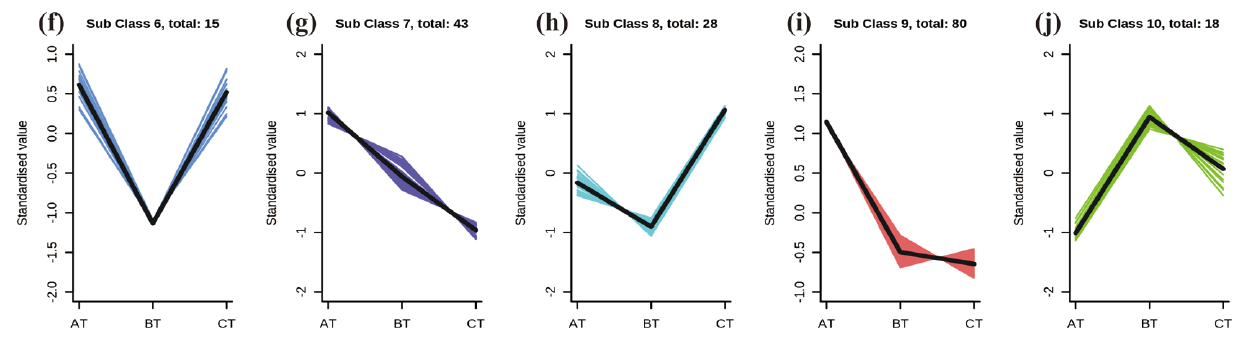
Figure 4. Widely targeted metabolomic analysis of rhizome sections of different ages in GK germplasm. ( A ) Metabolite classification. ( B ) Up- and down-regulated differential metabolites. Red boxes represent up-regulation, the blue boxes represent down-regulation. ( C ) Relative amounts of the highest differential metabolites in the three age classes. Red boxes represent annual age classes, blue boxes represent second-year age classes, and green boxes represent third-year age classes. ( D ) Venn diagram of differential metabolites. ( E ) Heat map of 16 key differential metabolites, “*” indicates an isomer. ( F ) Different age sections have rich metabolite classes. ( G ) K-means clustering analysis of differential metabolites in the ten